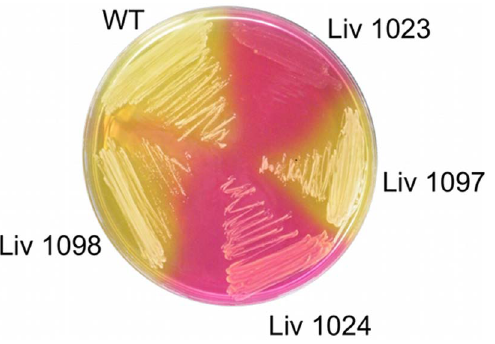
Figure 5. Survival on linoleic acid agar. Comparative survival of strains on BHI agar supplemented with 1 mM linoleic acid. Strains SH1000 (open circles), Liv1023 (SH1000 mtlD :: tet ) (filled squares), Liv1024 (SH1000 mtlABFD :: tet ) (open triangles) and Liv1098 (SH1000 mtlD :: tet pMJH71) were diluted in PBS and equivalent volumes were plated onto the agar. SE from triplicate experiments is shown with error bars inside symbols.